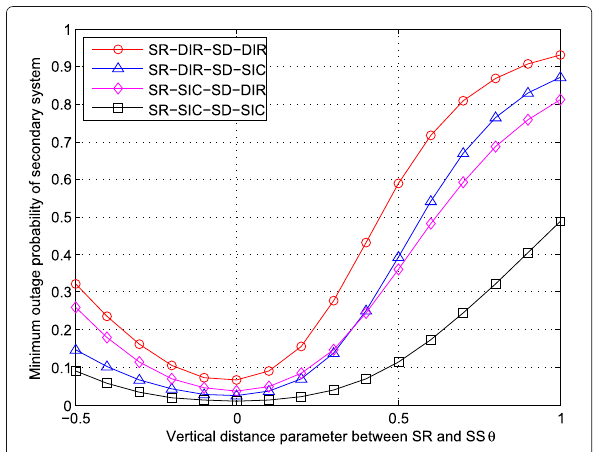
Fig. 14 Minimum outage probability of secondary system vs the distance factor θ